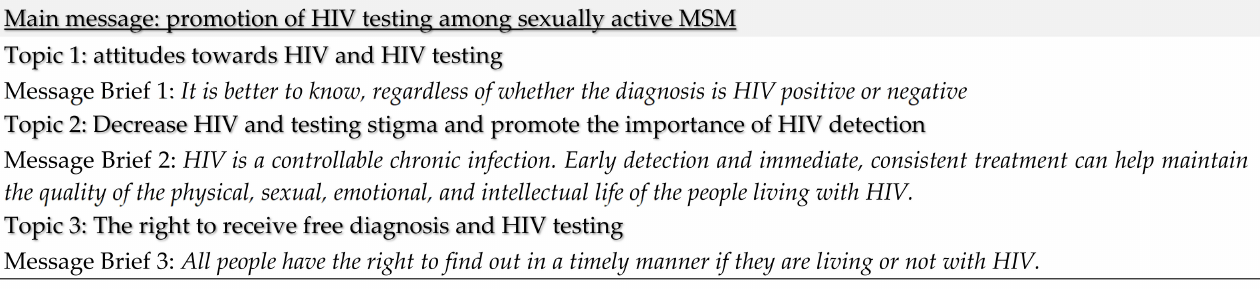
Figure 1. Message